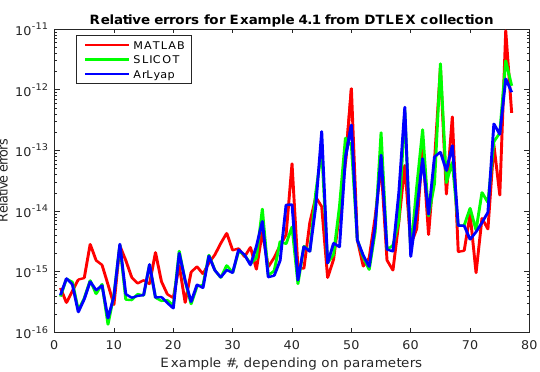
Figure 9. Relative errors for DTLEX 4.1 series of examples; tolerance ε 2